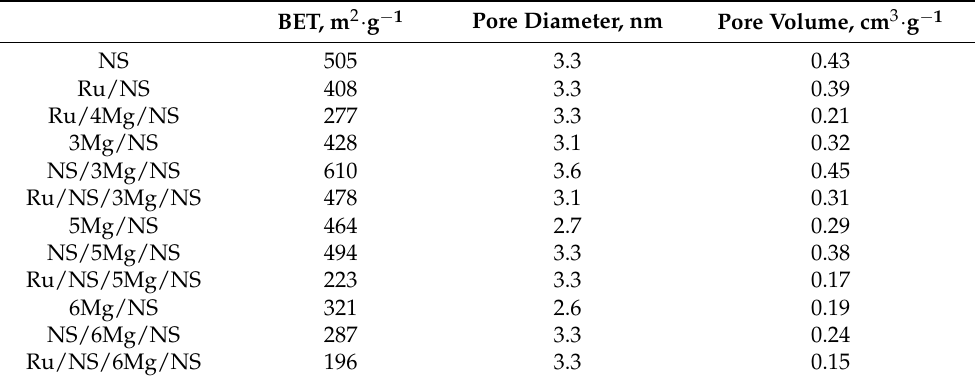
Table 1. Textural properties of the catalysts.